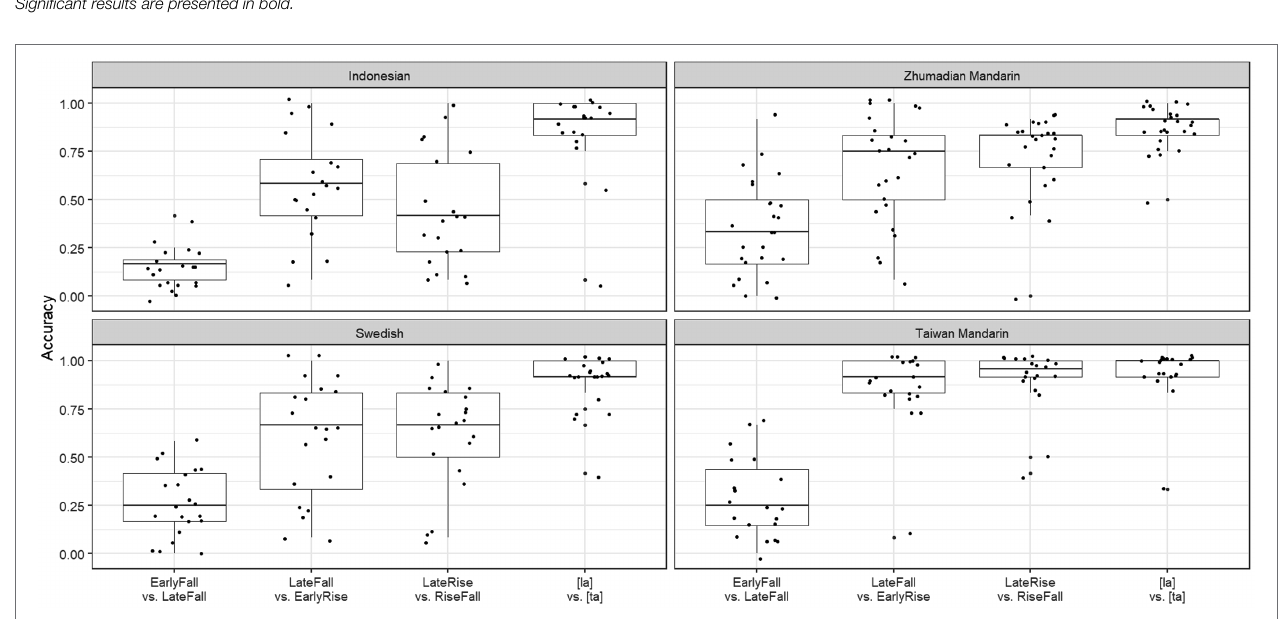
FIGURE 7 | Boxplots and scatterplots for four contrasts and four language groups.